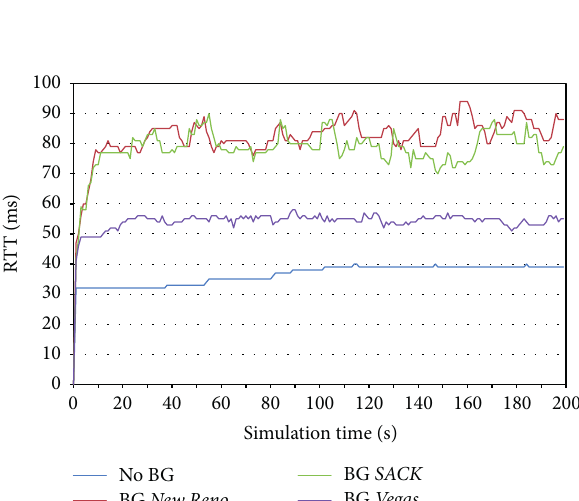
Figure 6: Network topology used in the tests.